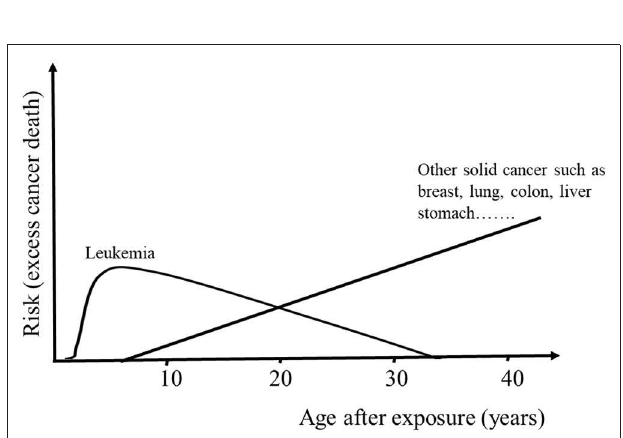
FIGURE 2 | Schematic overview of the documented findings regarding the late effect of the bomb-released radiation on cancer mortality throughout life. Leukemia risk shows a linear-quadratic response; increased in the early period after bombing then decreased, whereas other solid cancers followed a linear manner; continuing to increase as the cohort